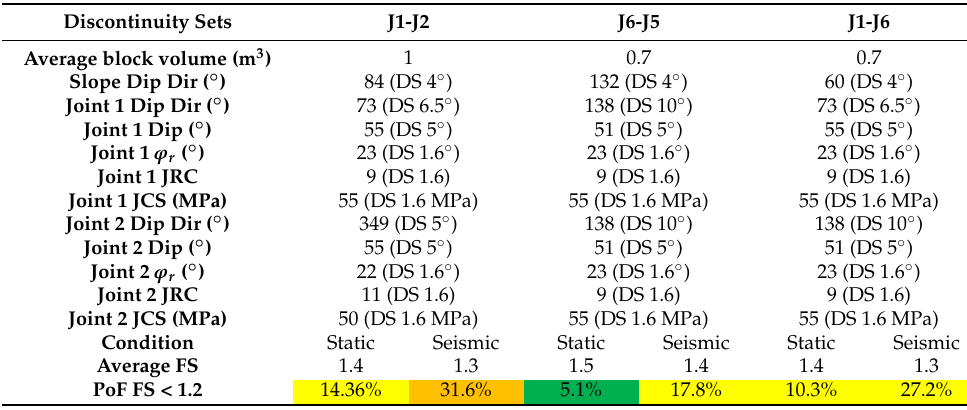
Table 11. Probabilistic stability analysis results for wedge sliding.